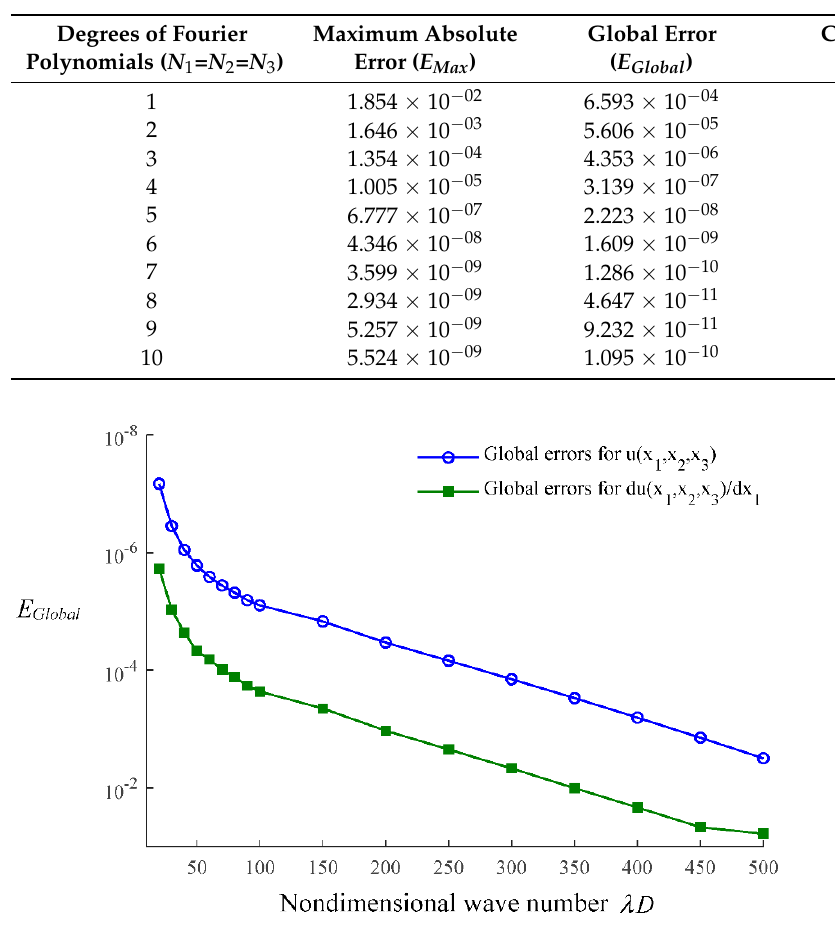
∂ ∂ with respect to different values of non-dimen-